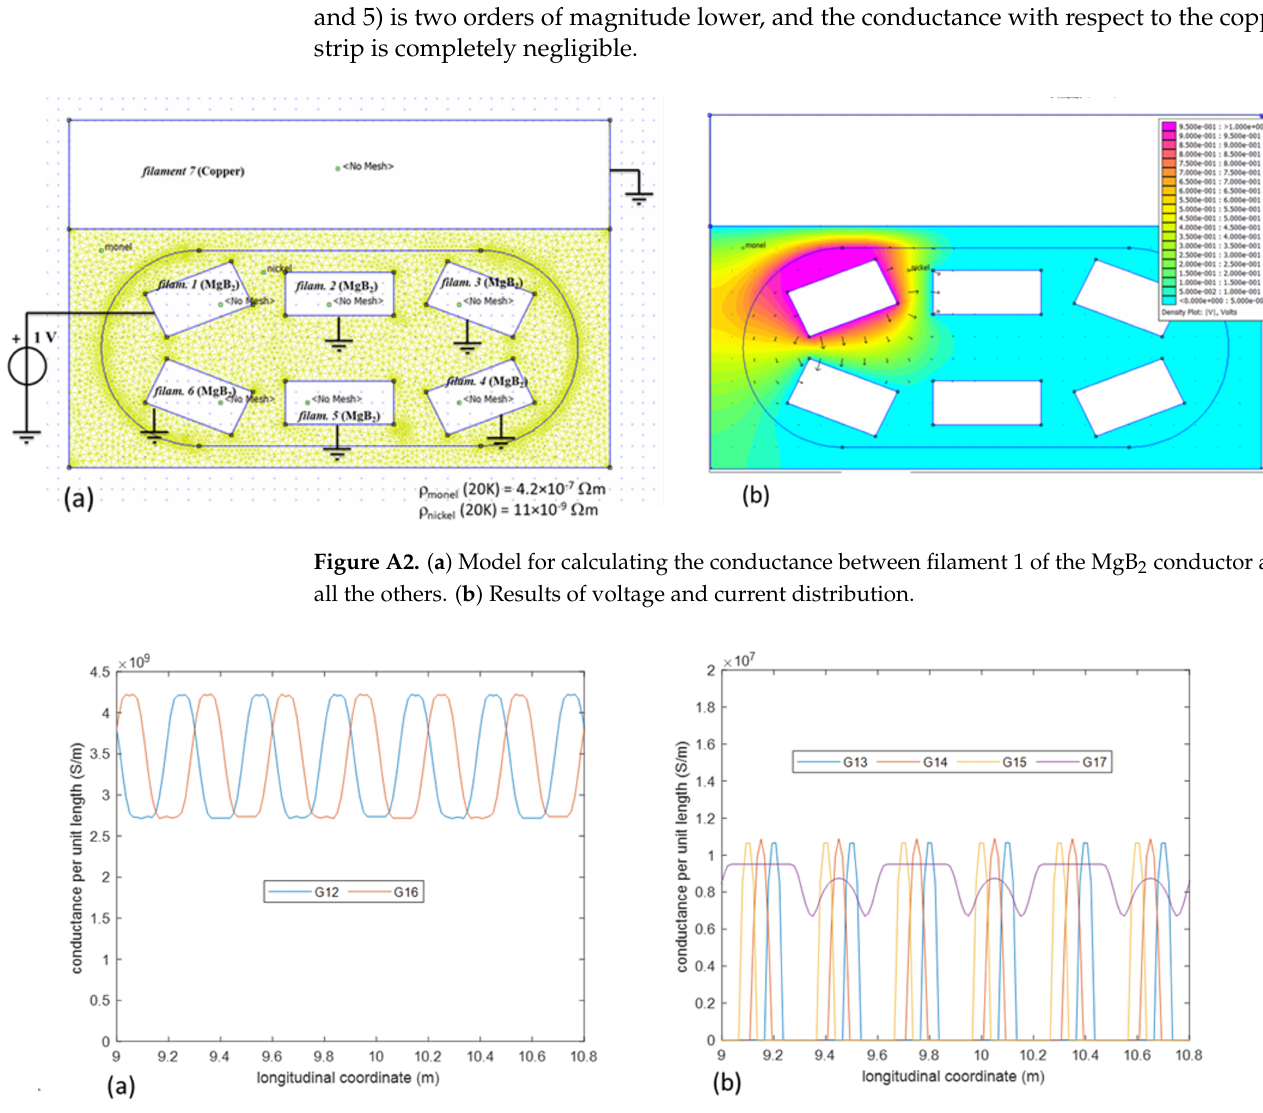
Figure A3. Conductance per unit length along three twisting pitches for ( a ) filament 1 and ( b ) all the